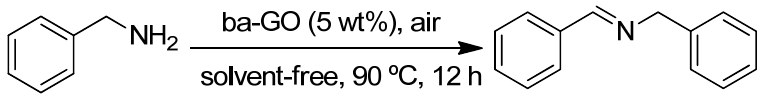
Figure 7. Aerobic oxidation of benzylamine using base then acid washed graphene ‐ oxide (GO) as a catalyst.